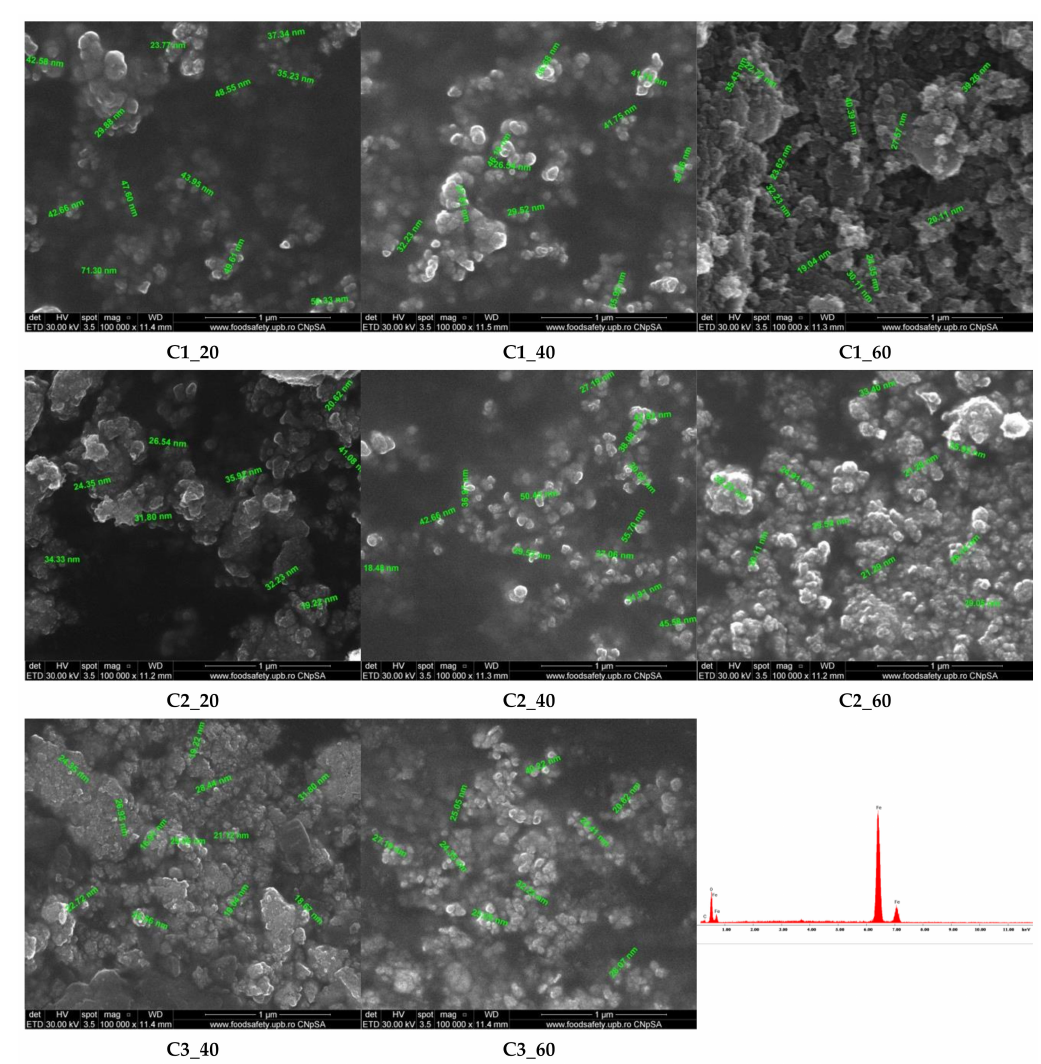
Figure 7. SEM images and EDX spectrum for the MNPs synthesized through the LoC